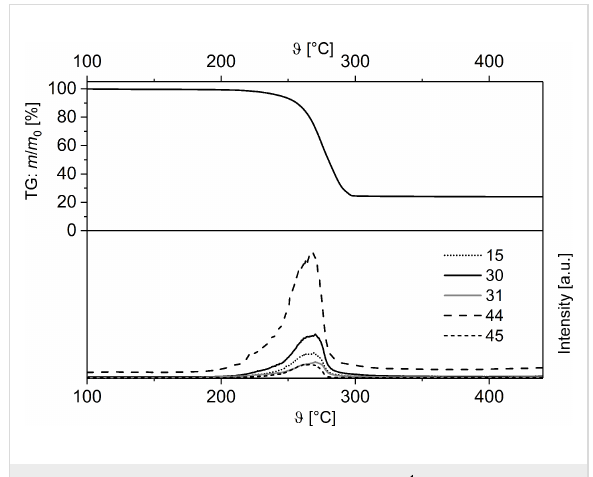
Figure 5: TG trace (top) (Ar, gas flow 60 mL min − 1 , heating rate 10 °C min − 1 ) and selected mass-spectrometric scans (bottom) of 2 : m / z = 45 (C 2 H 5 O + ), 44 (CO 2+ ), 31 (CH 3 O + ), 30 (CH 2 O + ), and 15 (CH 3+ ).